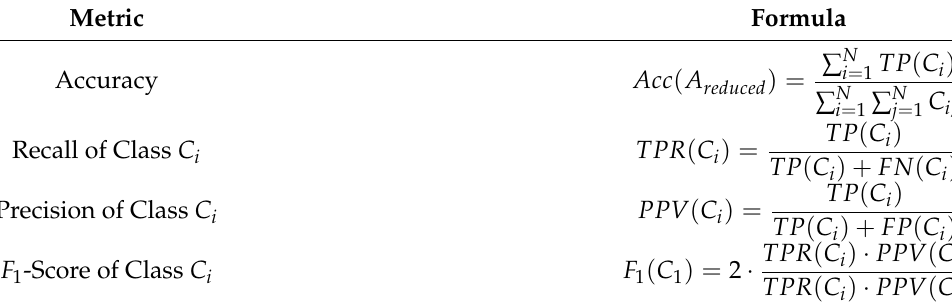
Table 3. Performance metrics for a multiclass confusion